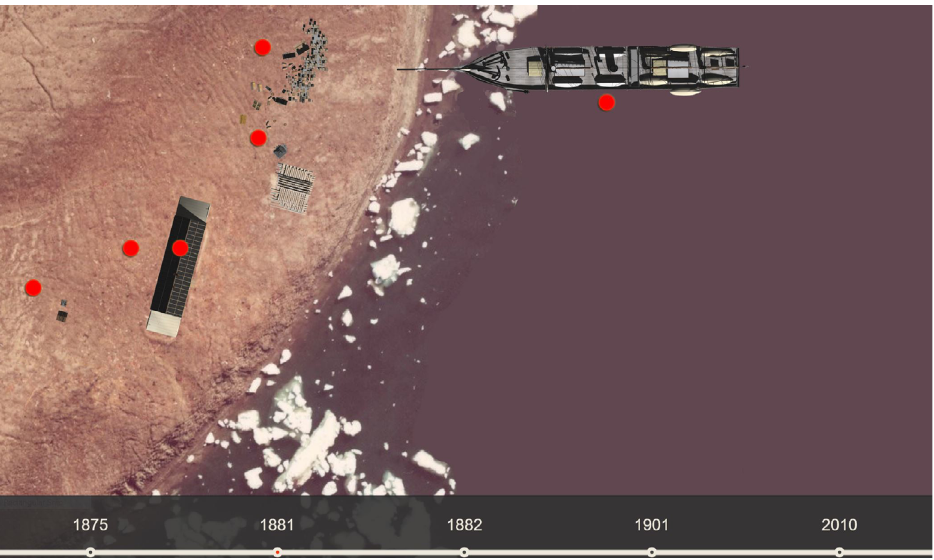
Figure 3. Virtual timeline, 1881 (Lady Franklin Bay